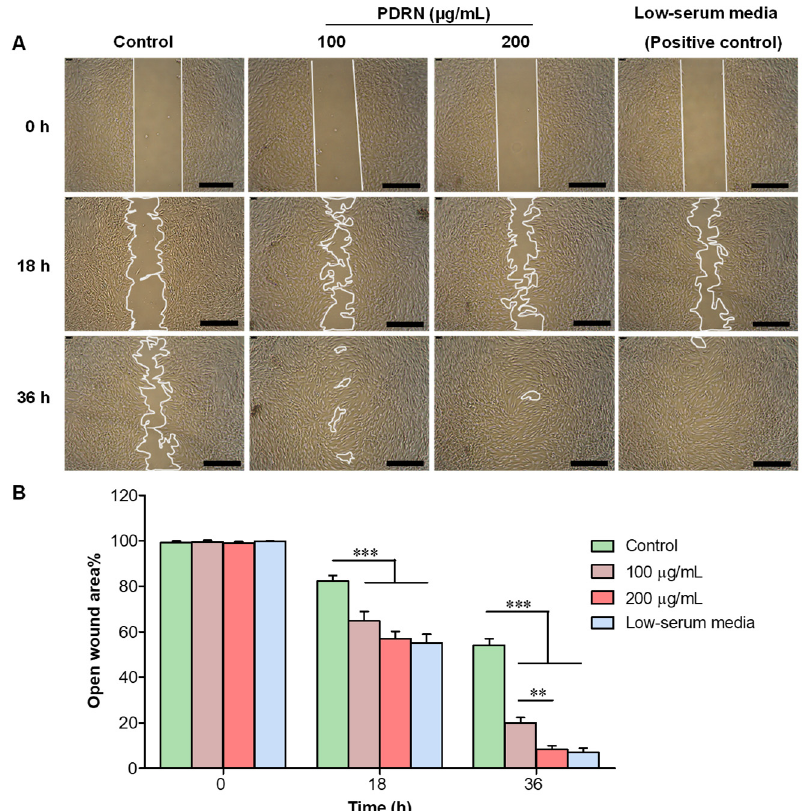
Figure 1. Effect of PDRN on in vitro wound healing in HDFs. ( A ) Representative images of in vitro scratch assay, and ( B ) quantification of cell-free area of HDFs upon PDRN treatment (100 and 200 µg/mL) at 0, 18, and 36 h. Results are presented as means ± standard deviation (SD) based on the time point at 0 h (Two-way ANOVA, ** p < 0.01, *** p < 0.001, Scale bar 500 µm, n = 3).